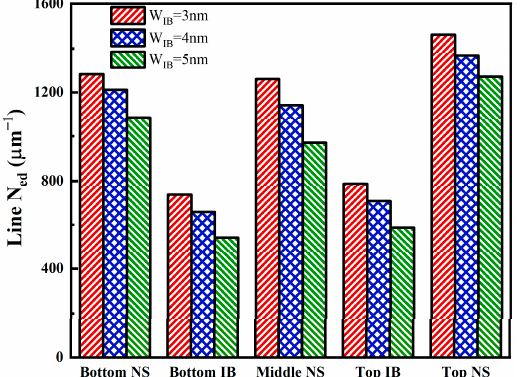
Figure 6. Total line electron density (N ed ) of different parts of channels with different W IB at V GS = V DS = 0.7 V.